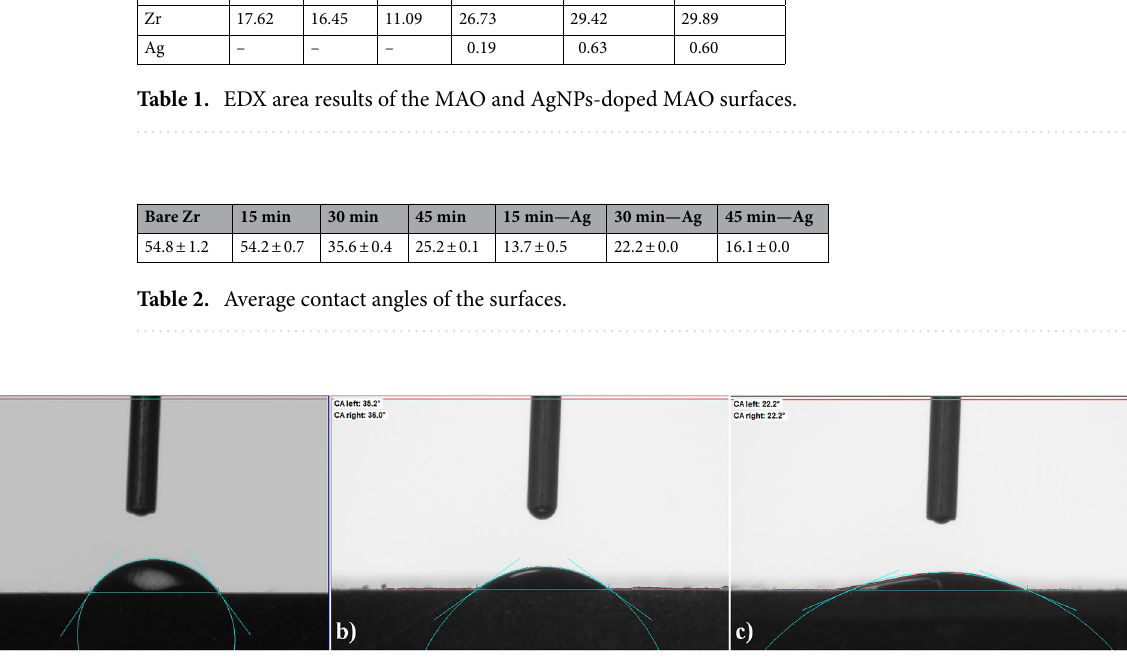
Fig. 2. This refers to improve polarity of surface due to the existence of Zr–OH groups on the MAO surfaces. Polar surfaces improve wettability and exhibit low contact angles 58 . However, AgNPs-doped MAO surfaces indicate very low contact angles respect to the MAO surfaces. It is well known that a hydrophilic surface tends to enhance cell adhesion, cell differentiation, bone mineralization and biological activity 59 . In vitro immersion test in SBF is typically carried out to estimate the predicting bioactivity of a biomaterial surface. To analyze the bioactivity of bare Zr and AgNPs-doped MAO surfaces, in vitro immersion test was carried out at 36.5 °C under SBF for 10 days. The surface morphology and phase composition of bare Zr and AgNPs-doped MAO surfaces after immersion test are shown in Figs. 8, 9, respectively. Red arrows on Fig. 8 indicate newly formed secondary particles on bare and AgNPs-doped MAO surfaces at post-immersion in SBF. As shown in Fig. 9, bioceramic composite phases such as Zr (zirconium, JCPDS # 005-0665), m-ZrO 2 (mono-